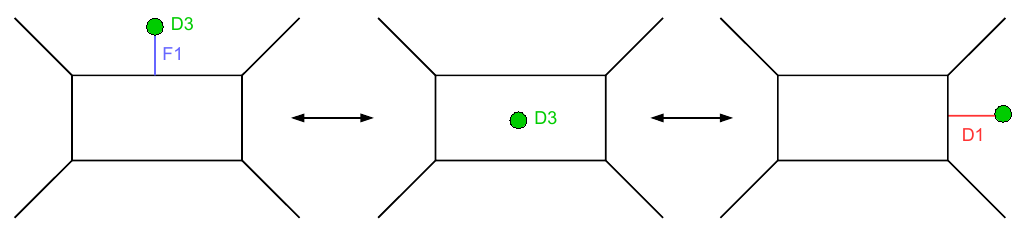
Figure 2 . Hanany-Witten string creation/annihilation e(cid:11)ects as we move a D3 brane (green dot) in the x 56